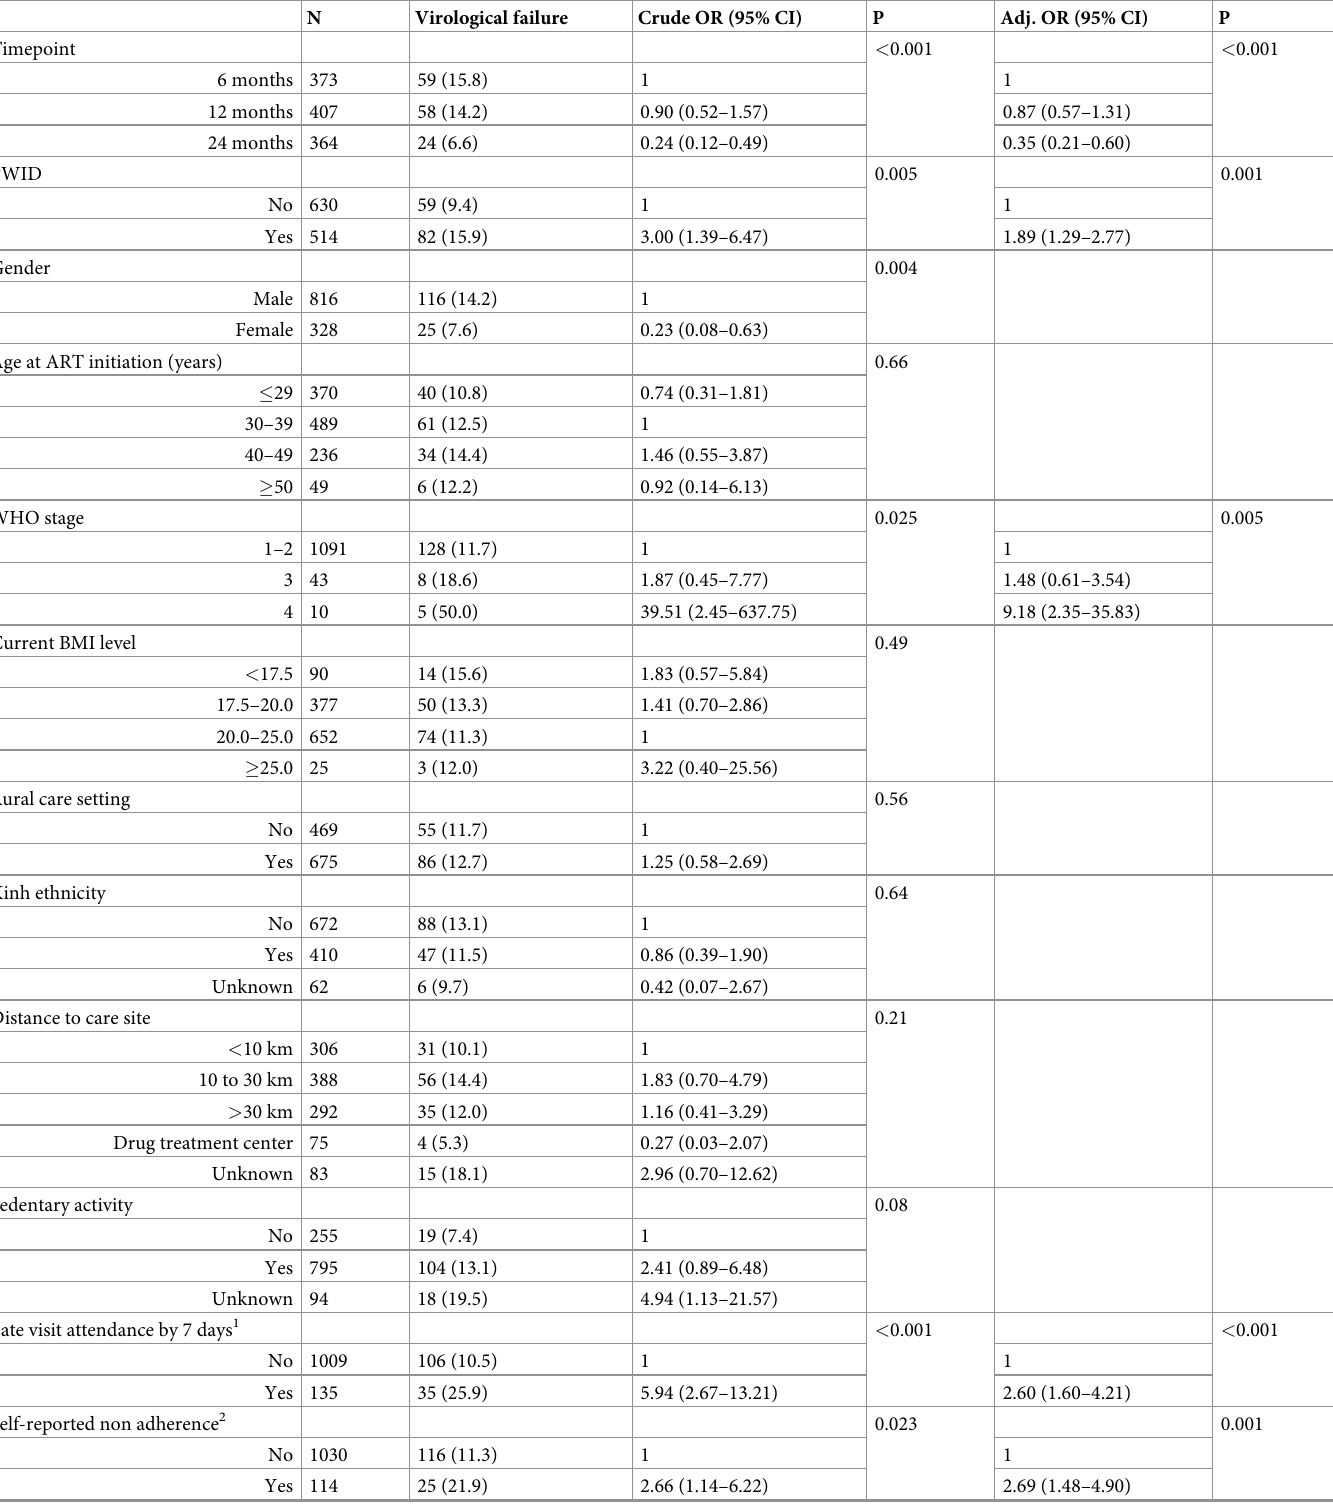
Table 4. Factors associated with virological failure defined as a viral load � 1,000 copies/mL (mixed-effects logistic regression